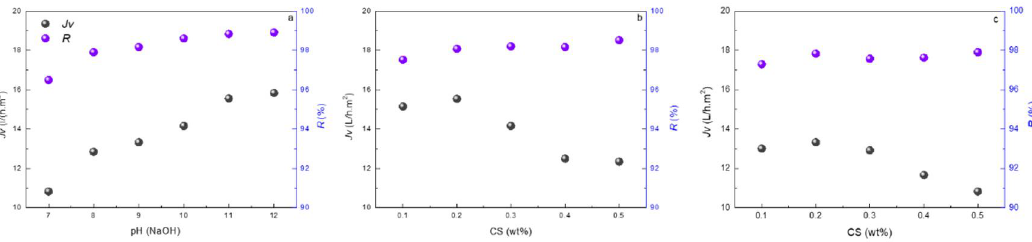
Figure 7. ( a ) Effects of NaOH concentration on membrane performance of PAUt membranes; Effects of CS concentration on membrane performance of ( b ) PAUt-CS and ( c ) PAUt-PDDA/PSS/CS. Testing conditions: 1.55 MPa and 2000 ppm NaCl as feed solution at 25.0 ± 2.0 °C.